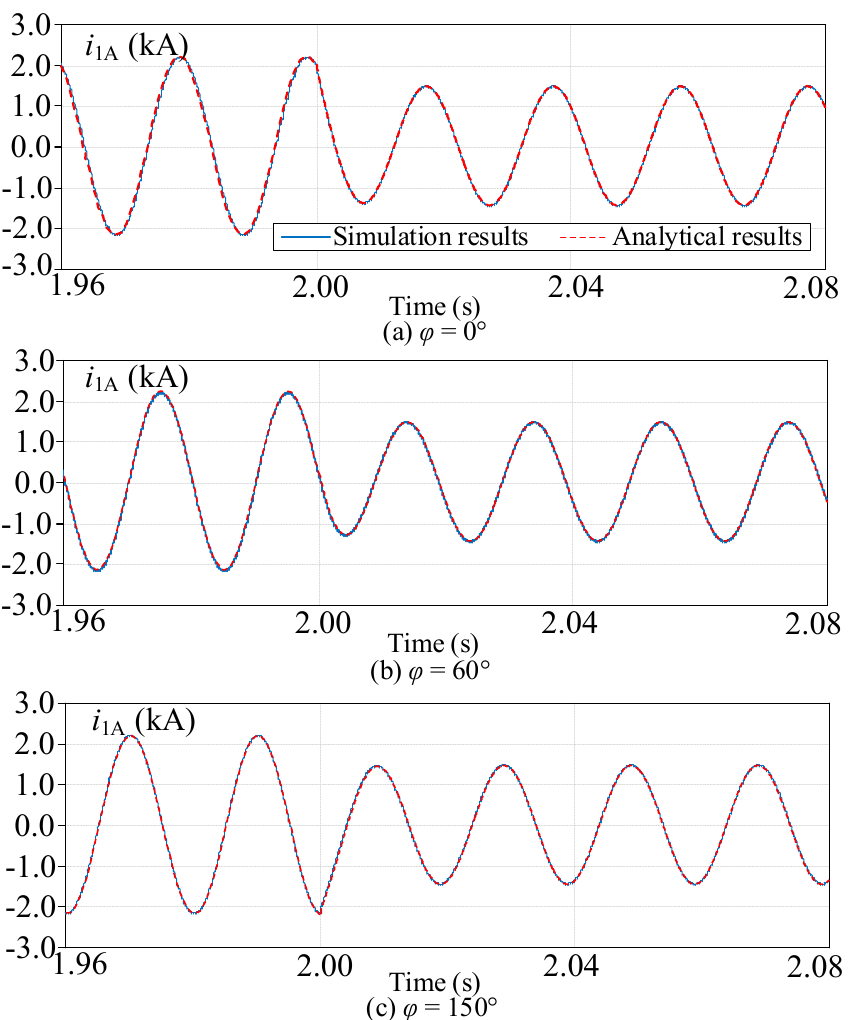
Figure 10. Simulation results of the wind turbine’s output current with different grid voltage phase, φ , when the short-circuit fault